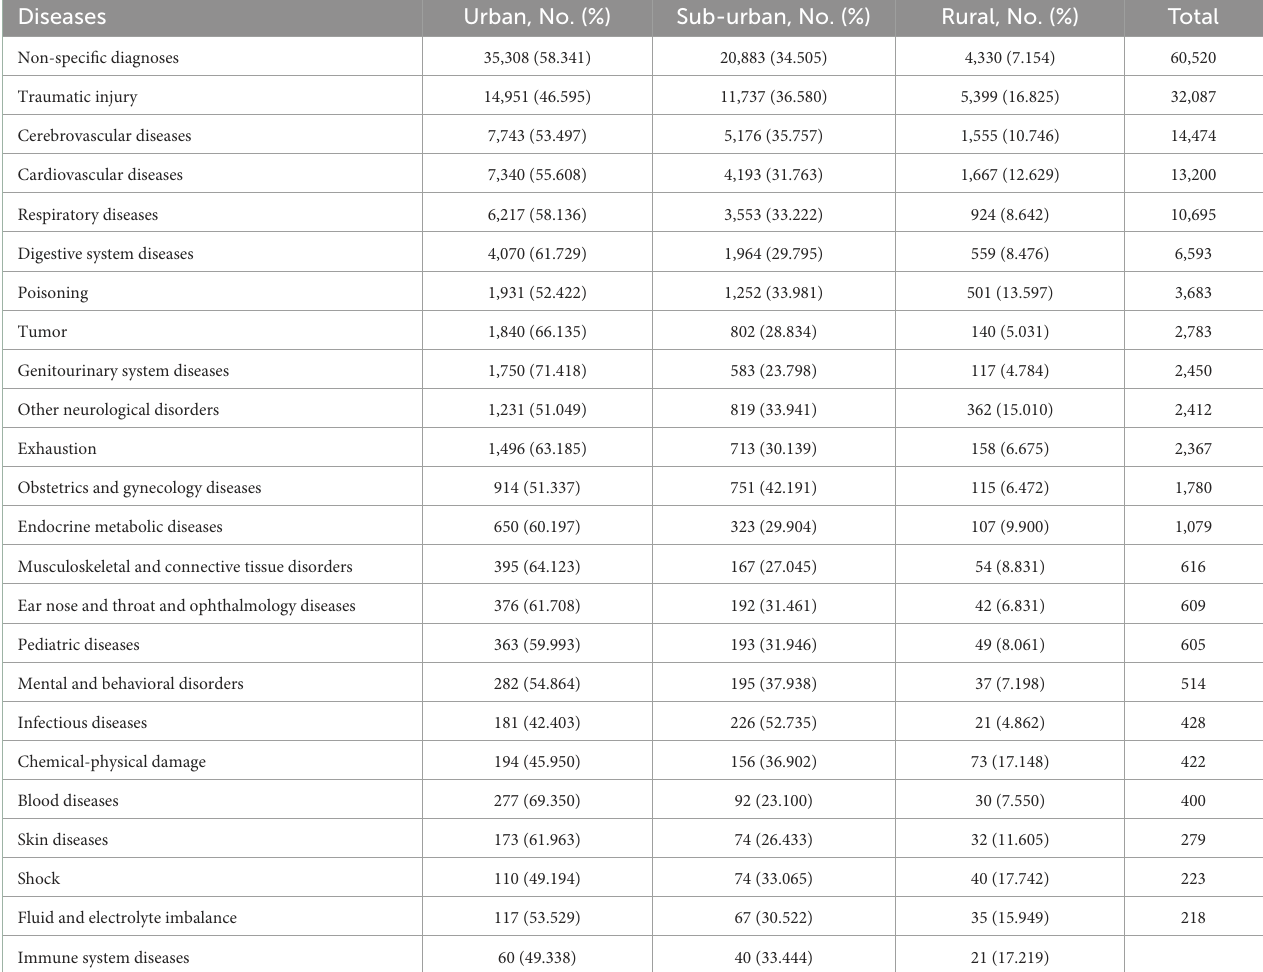
TABLE 1 Disease spectrum of patients using EMS in urban, sub-urban, and rural of Tianjin, China, from 2017 to 2021. Diseases Urban, No. (%) Sub-urban, No. (%) Rural, No.